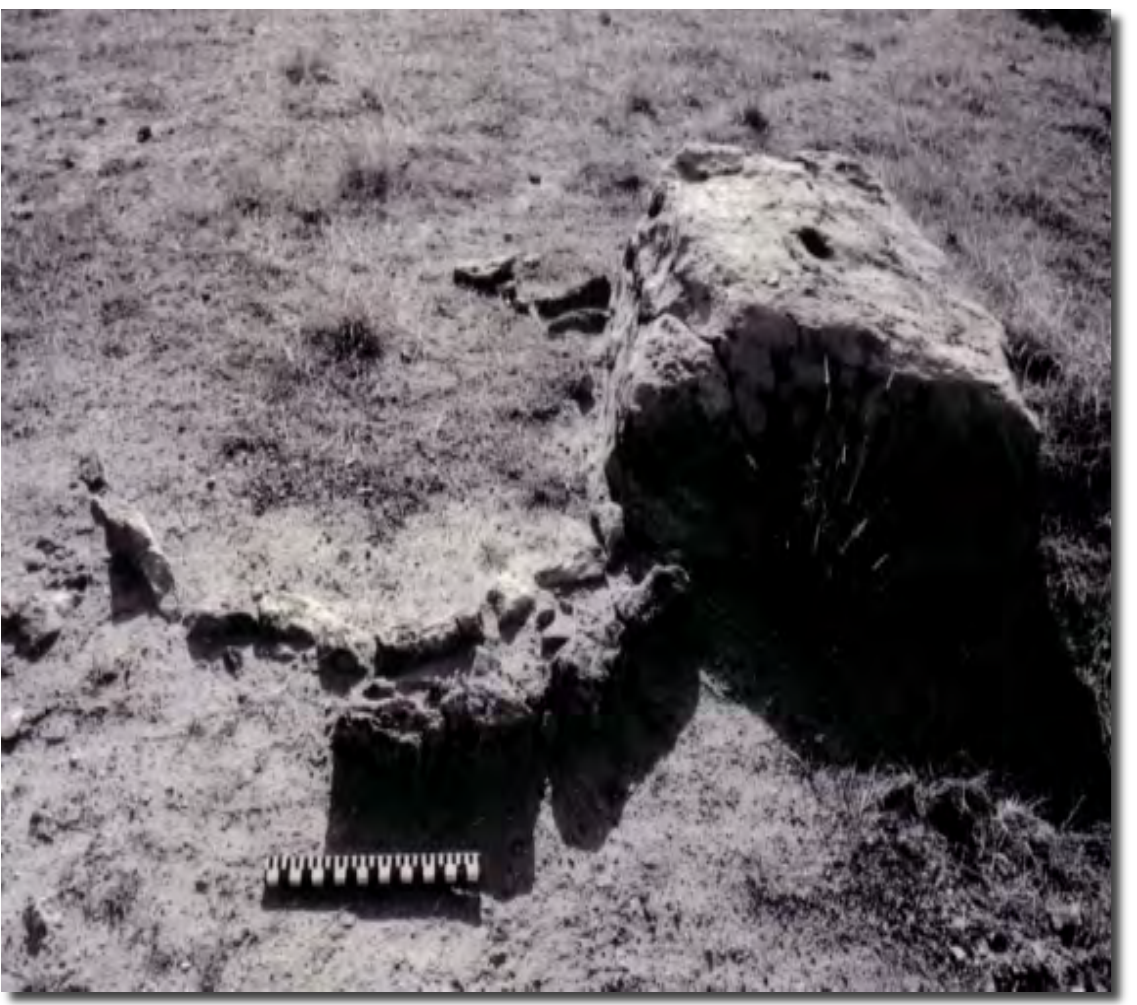
Figure 5. A semi-circular double row of stones, interpreted as the base of a low wall surrounding a possible threshing floor built against a large mortar rock, situated in the valley near the eastern foot of Mapungubwe Hill (Meyer 1998:Figure